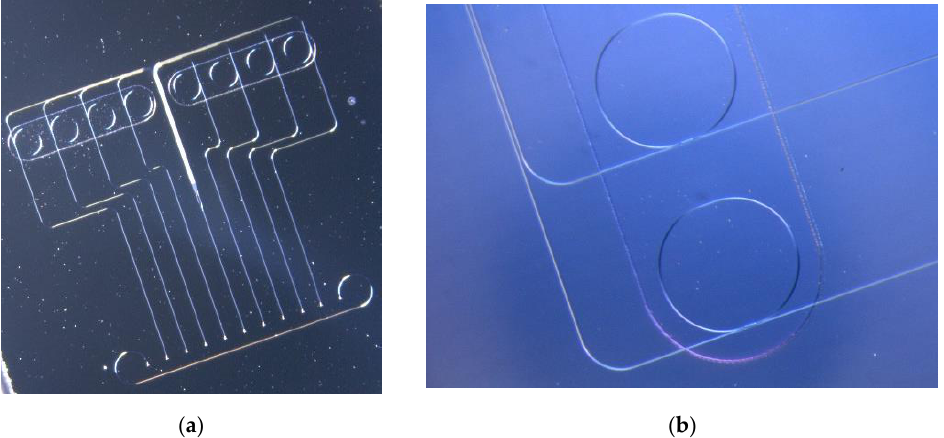
Figure 1. Optical pictures of ( a ) the fabricated biosensor PIC and ( b ) of the PIC close to the region of the RRs, where the window is opened to allow buffer/sample access.